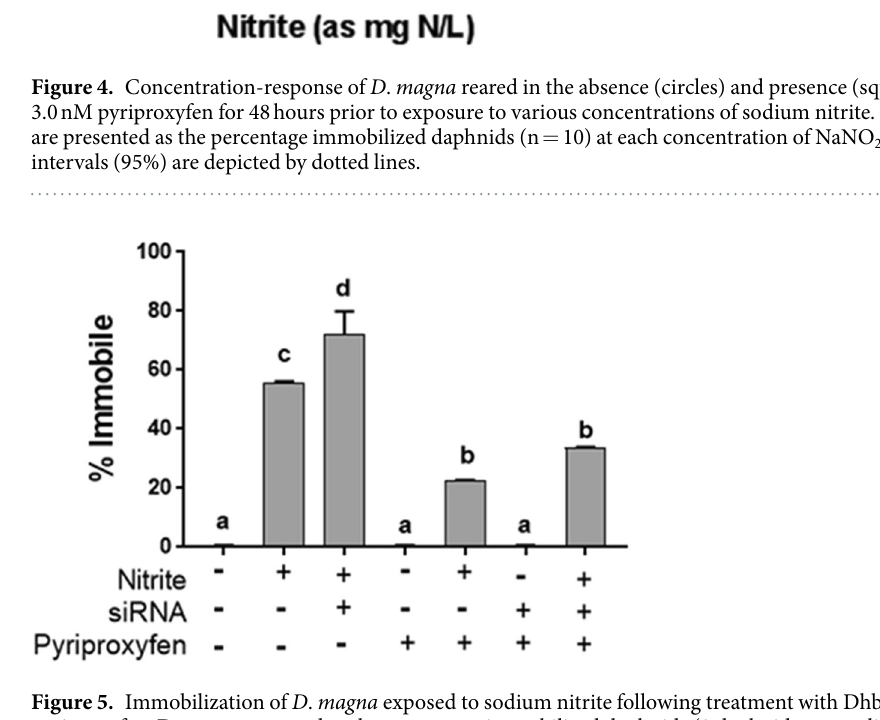
Figure 5. Immobilization of D . magna exposed to sodium nitrite following treatment with Dhb2 siRNA and/or pyriproxyfen. Data are presented as the percentage immobilized daphnids (9 daphnids per replicate, 2 replicates per treatment). Treatments denoted with different letters were significantly ( p < 0.05) different (One-way Analysis of Variance, Tukey’s Multiple Comparisons